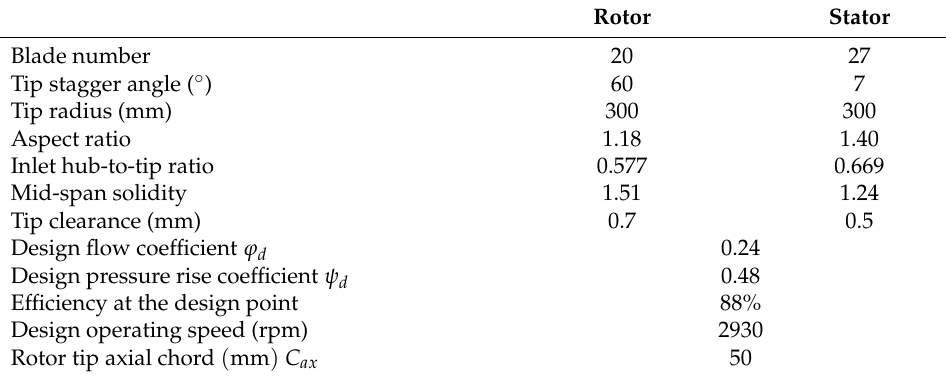
Figure 1. Schematic of the axial compressor. Table 1. Design parameters for the compressor.